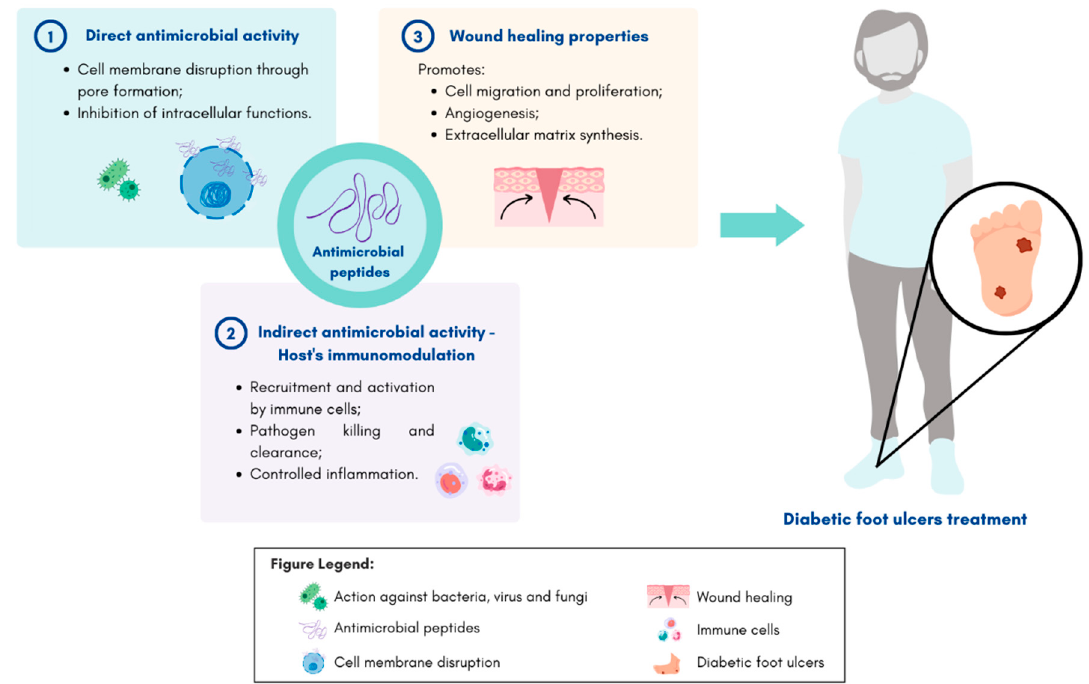
Figure 1. Schematic representation of antimicrobial peptides mechanisms of action and their potential application on diabetic foot ulcer treatment. Figure created in Canva.com (accessed on 24 January 2023).